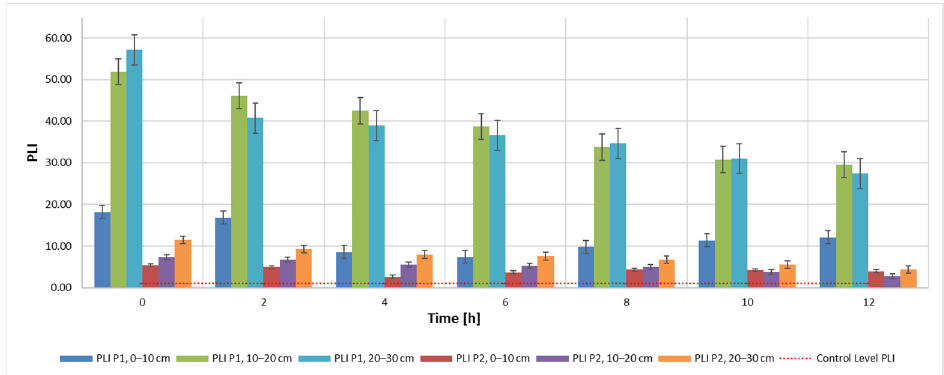
Figure 5. PLI—pollution load index during the extraction process according to admissibility limits and sampling depth using 20 mL 9K medium.